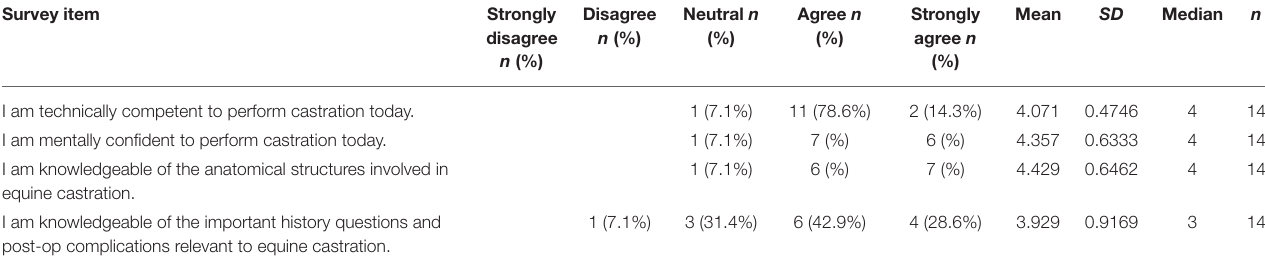
TABLE 5 | Results of student confidence survey prior to live horse castration, no model experience. Survey